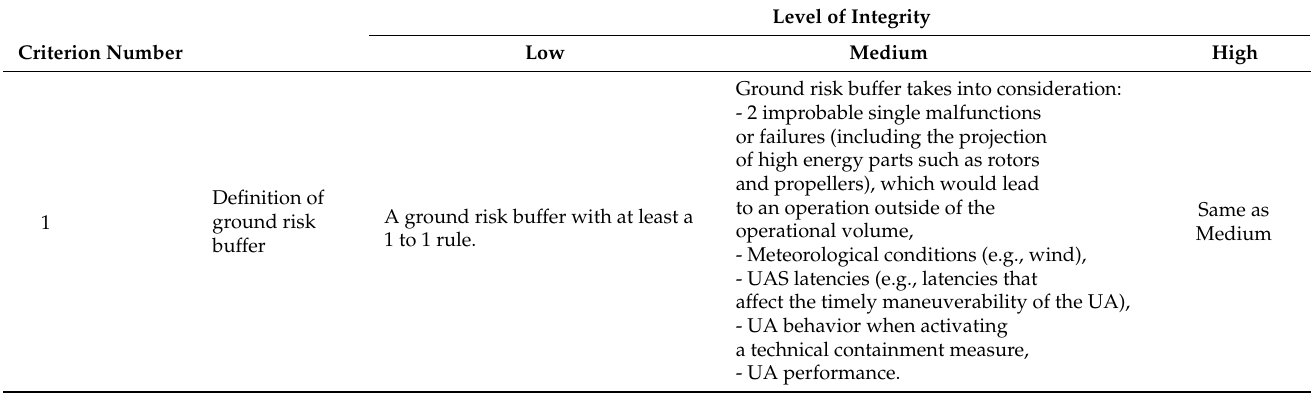
Table 6. Level of integrity assessment criteria for ground risk of non-tethered M1 mitigations